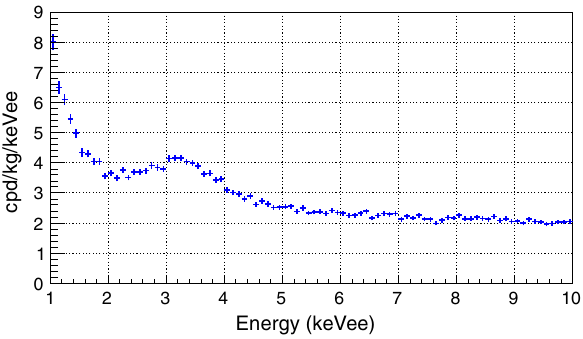
Fig. 3 Total anticoincidence energy spectrum of ANAIS-112 at low energy corrected for efficiencies ( ∼ 10% of the first year of data unblinded)